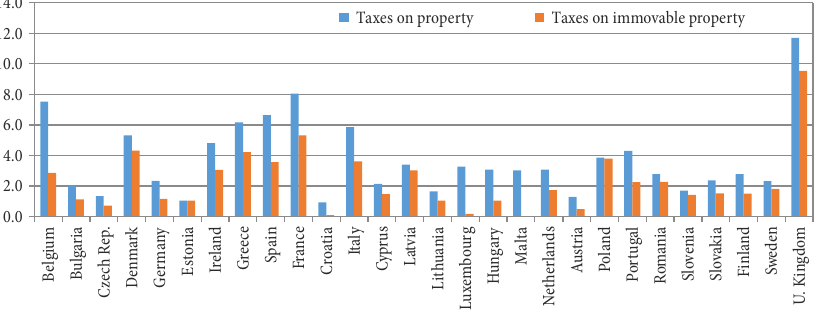
Fig. 1. Share of total property taxes and immovable property taxes in the EU States